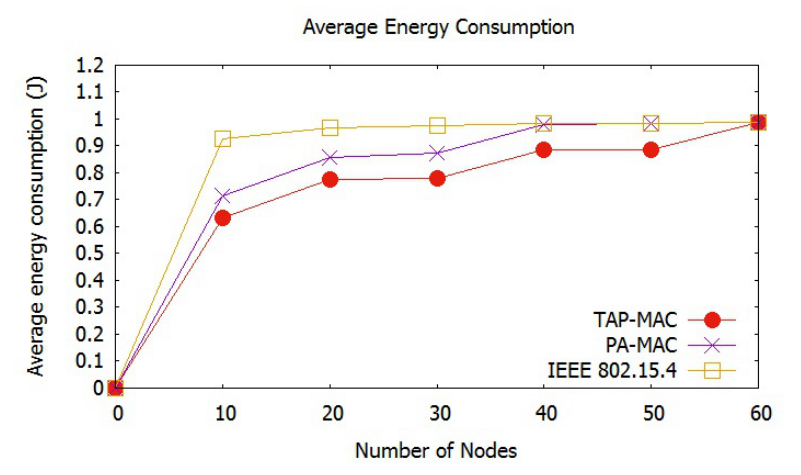
Figure 16. Scenario 3: Average energy